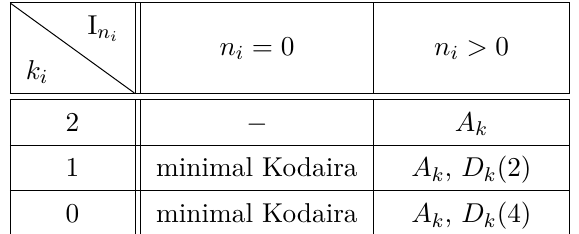
Table 2 . Allowed singularity types of special fibers in the central surface components Y i of a Kulikov Weierstrass model. Note that the first column distinguishes the three types of surface components Y i based on the self-intersection − k i := B i · B i of the base components and the first row refers to the Kodaira type I of the generic fibers. The third column uses the notation of (3.21), (3.22). The n i numbers in the parentheses count the D -type singularities. For n 0 , also singularities of Type D i > k for 0 ≤ k ≤ 3 can